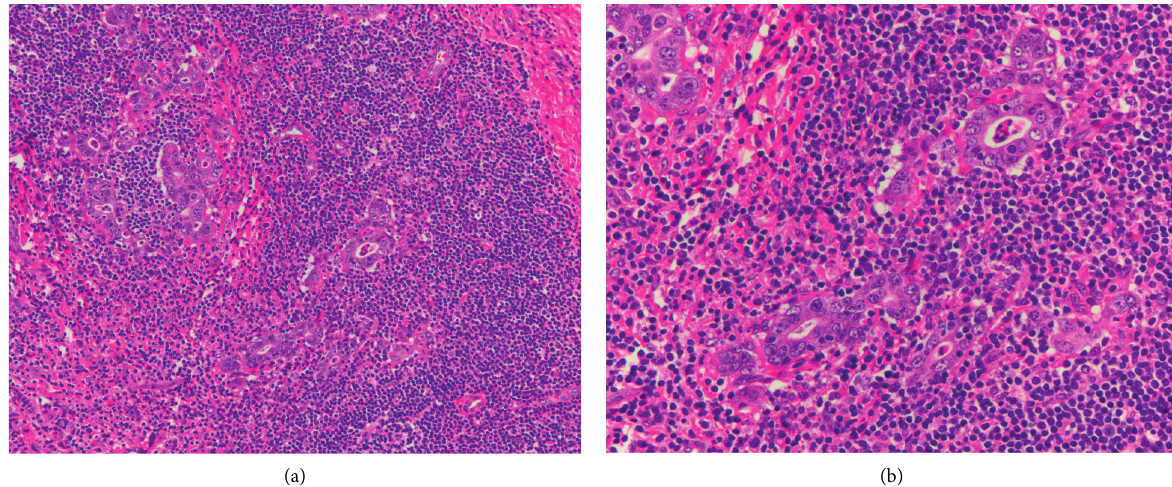
Figure 5: Infiltrating malignant glands are intimately associated with a dense lymphoid infiltrate (a). Intraepithelial lymphocytes are also present (b)